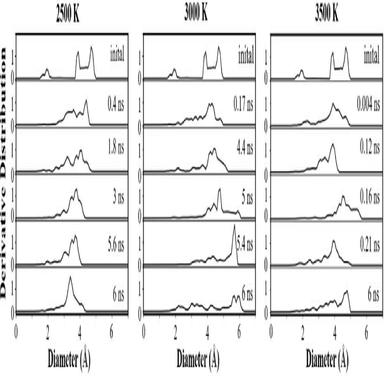
The pore size distribution (PSD) diagrams over time for the C70 conversion products. The results were obtained by using a probe with a diameter of 0.5 Å.